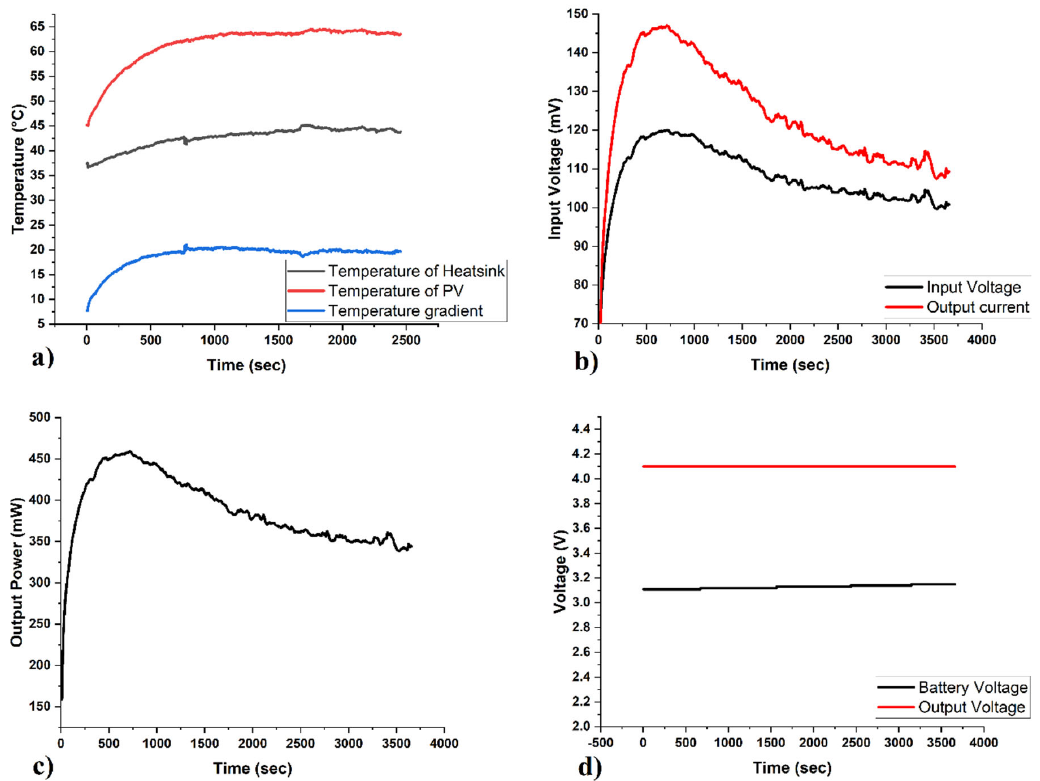
Figure 9. ( a ) PV, heat sink temperature and temperature gradient; ( b ) output current and input voltage; ( c ) harvested power (output power); and ( d ) battery and output voltage.